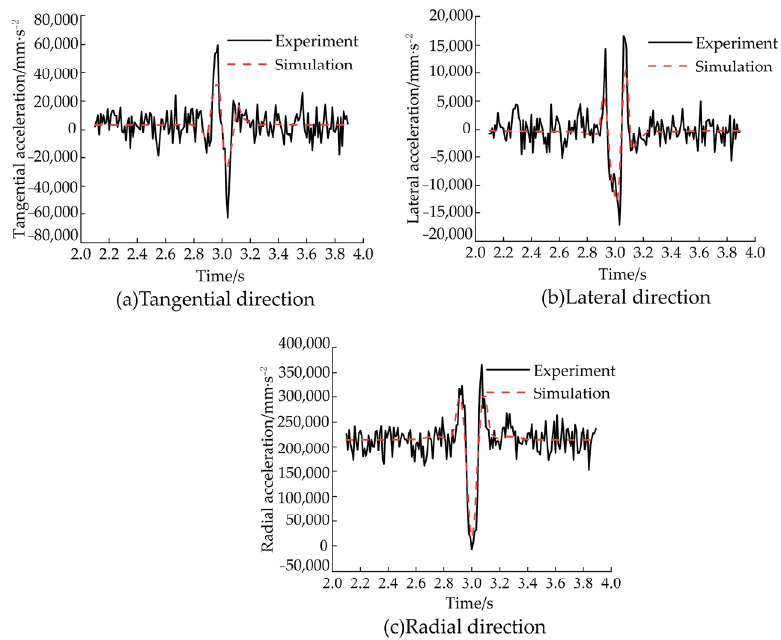
Figure 8. Comparison of experimental and simulation results.